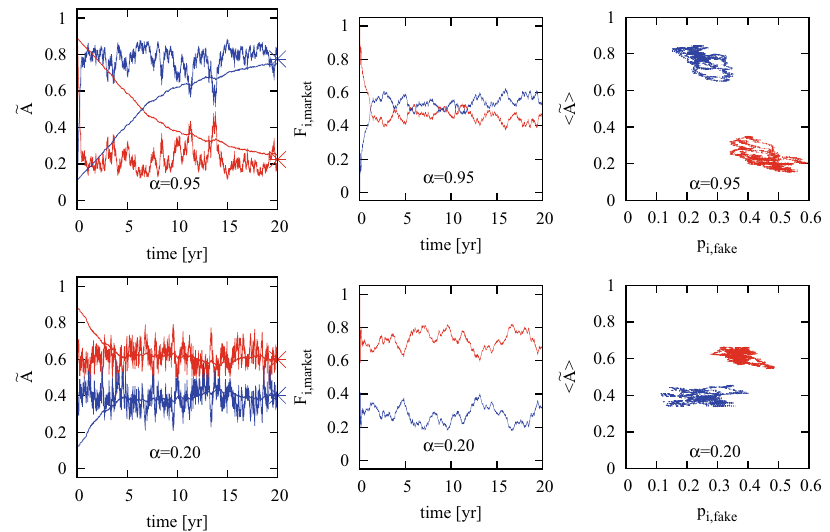
Fig. 7 We represent a media industry with N = 2 and editorial standards μ 1 = 0 . 3 (red) and μ 2 = 0 . 5 (blue) over a 20-year period. The top panels correspond to a situation with a high punishment ( α = 0 . 95), and the bottom panels to a situation with a low punishment ( α = 0 . 2). The left panels show the evolution of the two outlets’ audiences. The curves with large fluctuations correspond to the case Φ = 1 / 10, and the smooth ones to the case Φ = 1 / 200. The center panels show the evolution of the two fraction of news of the two outlets, averaged during the previous 100 days. The right panels show the relationship between the audience of an outlet and the fraction of false stories published by it, averaged during the previous 100days (color figure online)